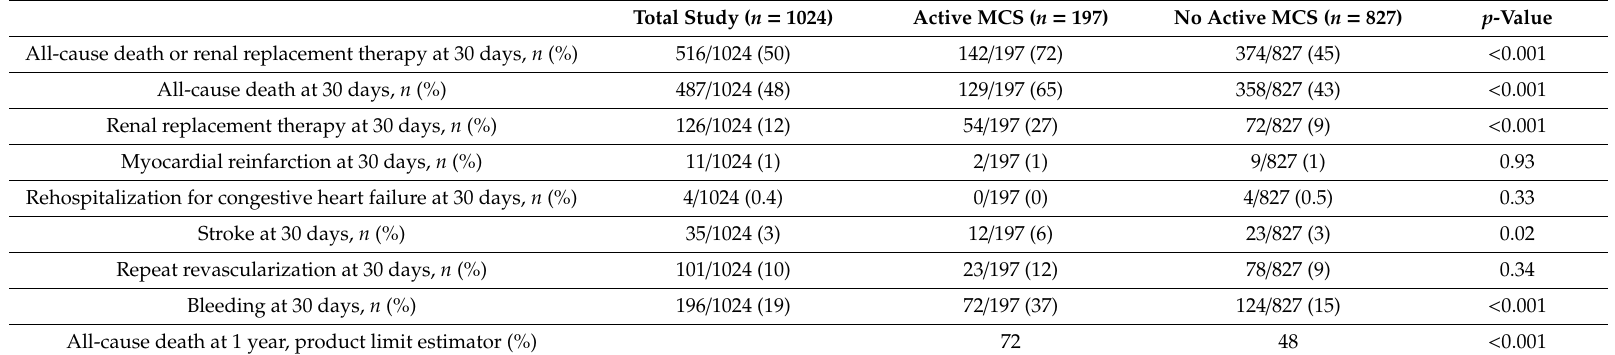
Table 2. Clinical outcome for patients with and without active mechanical circulatory support.